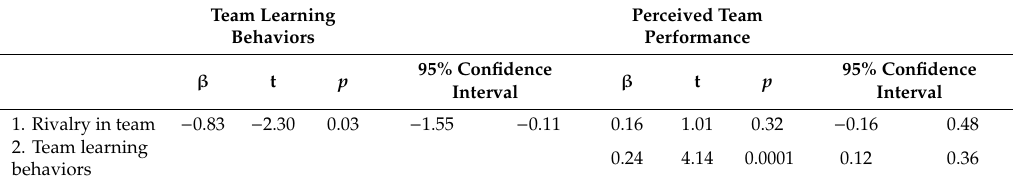
Table 3. Results of the mediated